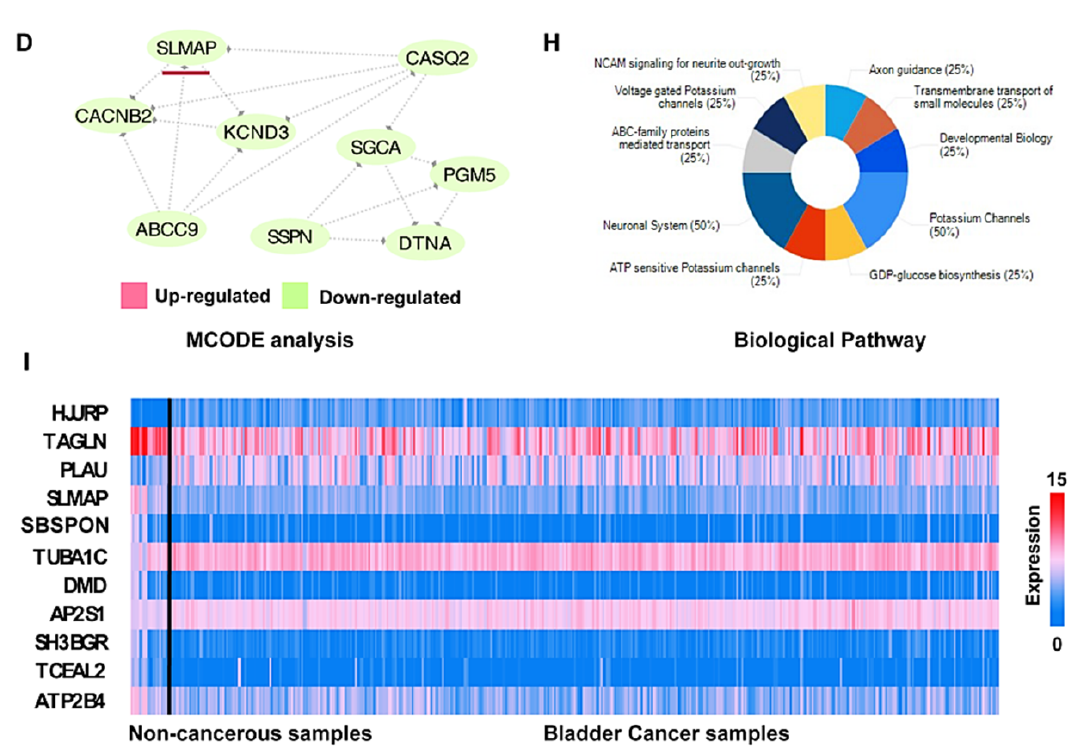
Figure 3. PPI network and biological pathway analysis for modules. ( A – D ) PPI network of the top four significant modules: the seed gene in each module is marked with a red underline; a label in red means the gene is upregulated, while a label in green means it is downregulated. ( E – H ) The top 10 biological pathways of each of the four modules. ( I ) Hierarchical clustering of 11 seed genes. The samples on the left of the black bar are noncancerous bladder tissue (regarded as controls) from the TCGA-BLCA dataset ( n = 19) and the samples on the right of the black bar are BCa samples from the TCGA-BLCA dataset ( n = 406). Upregulated genes are marked in red; downregulated genes are marked in